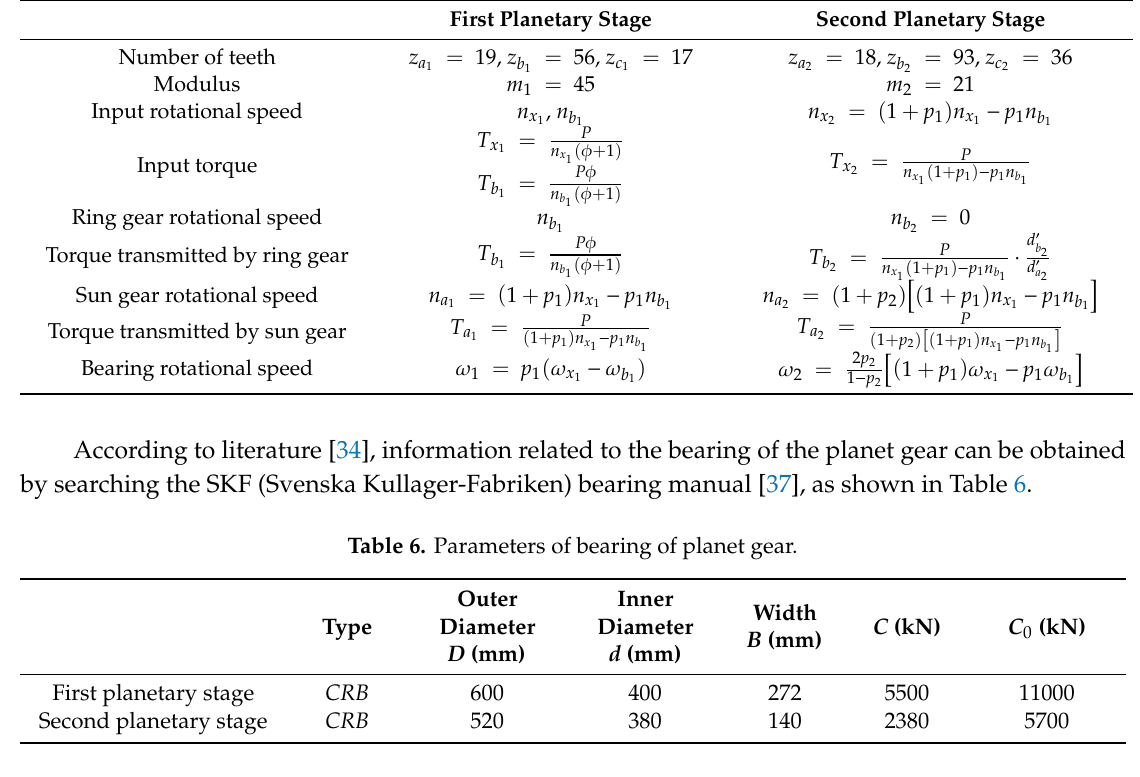
Table 5. Parameter summary of force and life model of planet gear and its bearing of DRWT.